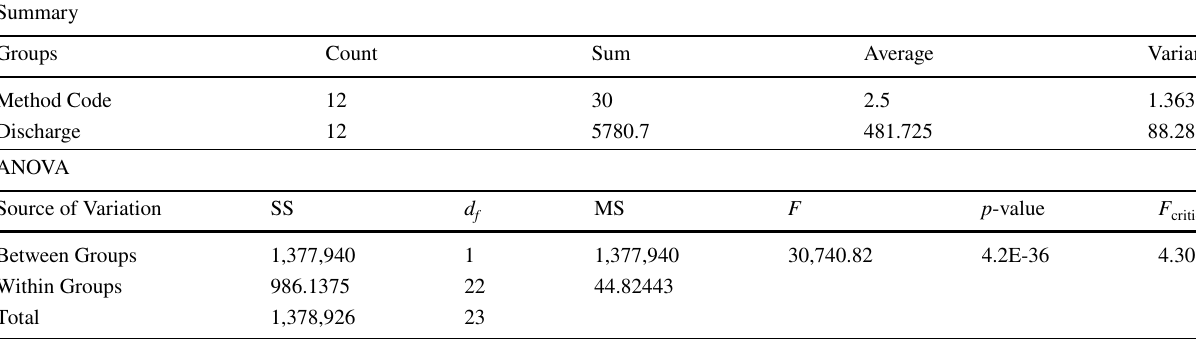
Table 18 Statistical evaluation between the observed and simulated discharges